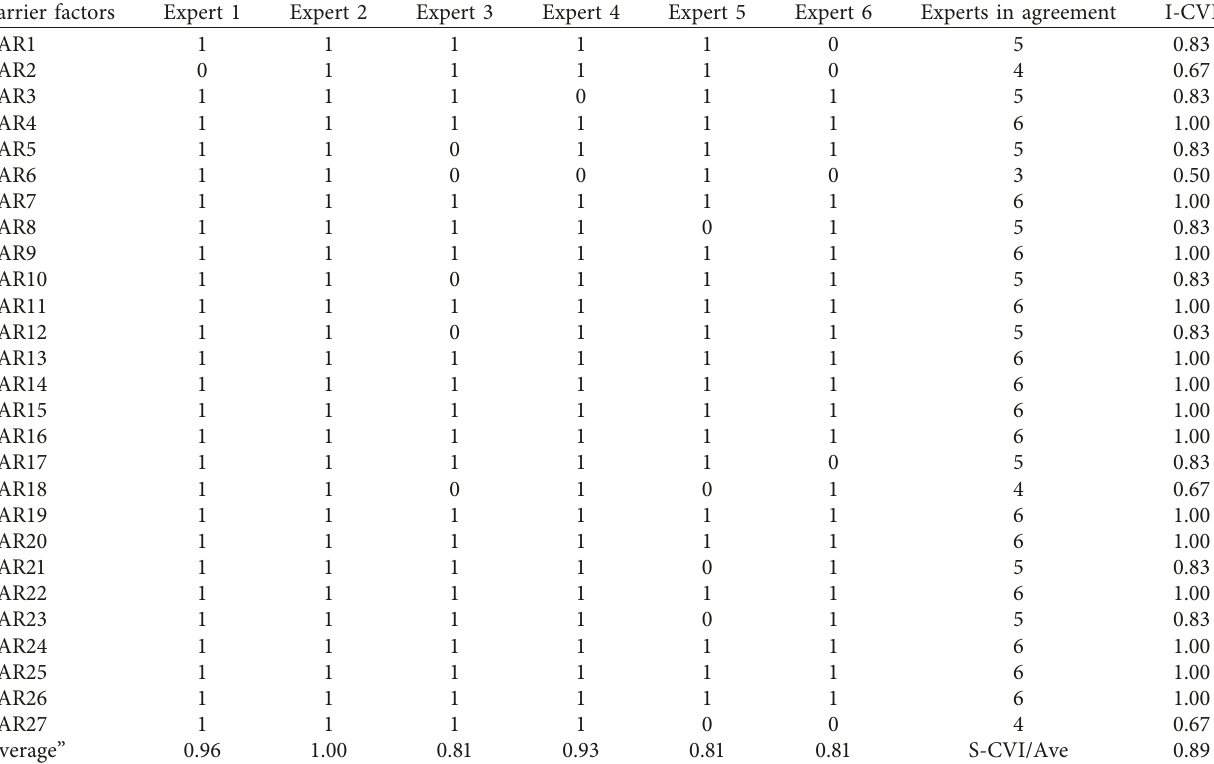
Table 2: Result of Content Validity Analysis for a Barriers of coordination for food security in Central Java. Barrier